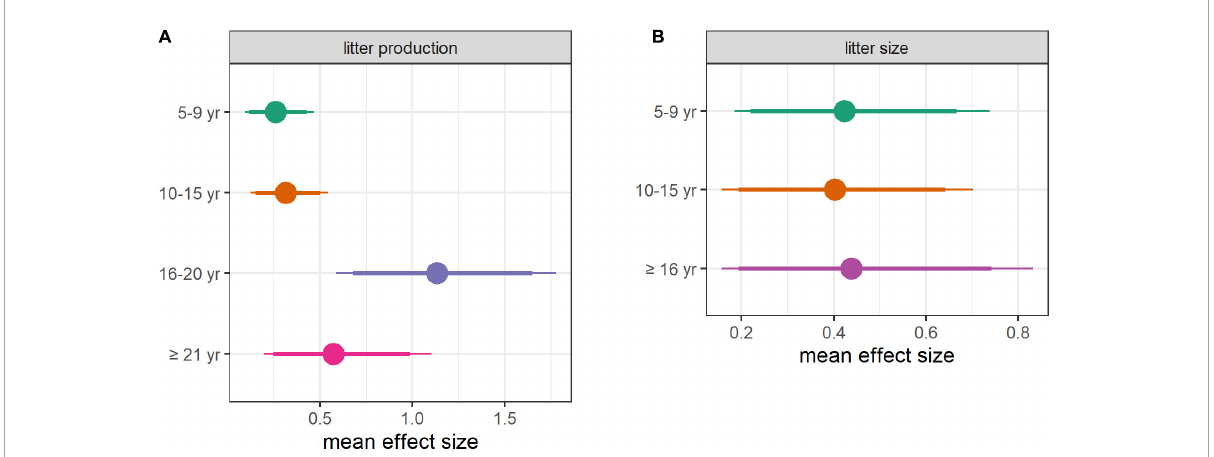
FIGURE5 Mean effect size of all environmental covariates. Mean effect size of environmental covariates for (A) probability of litter production and (B) probability of a large litter, depending on female’s age. The mean (dot) with 89% CRI (thick line), and 95% CRI (thin line) are provided. Each distribution was obtained by averaging values in the posterior distributions across environmental covariates, iteration by iteration and for each age groups. Posteriors were on the logit scale. The models used for this figure included DateBreakUp as the sea-ice covariate (see Appendix 3, Supplementary Figure 9 for the version obtained when including DateFreezeUp